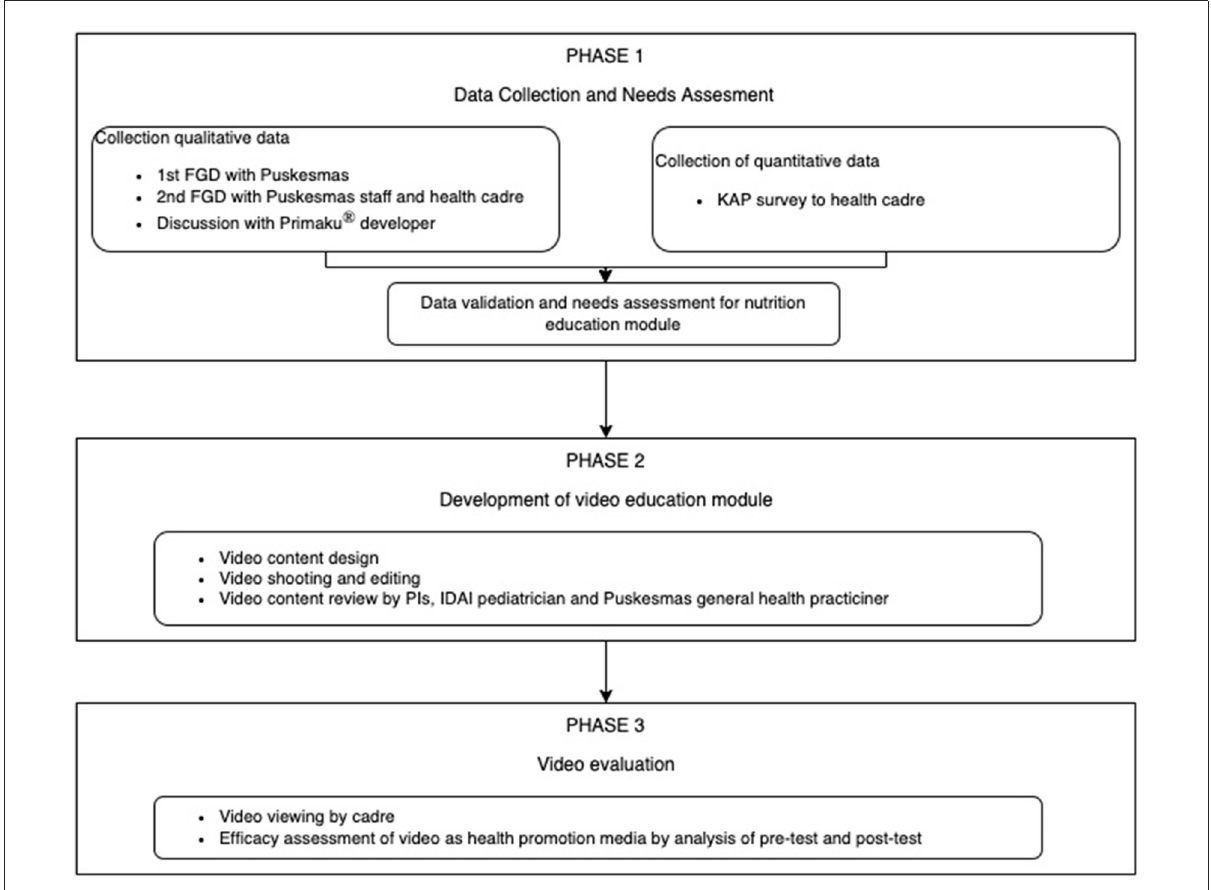
FIGURE1 Three phases of the study: data collection and needs assessment, development of video education module, and video